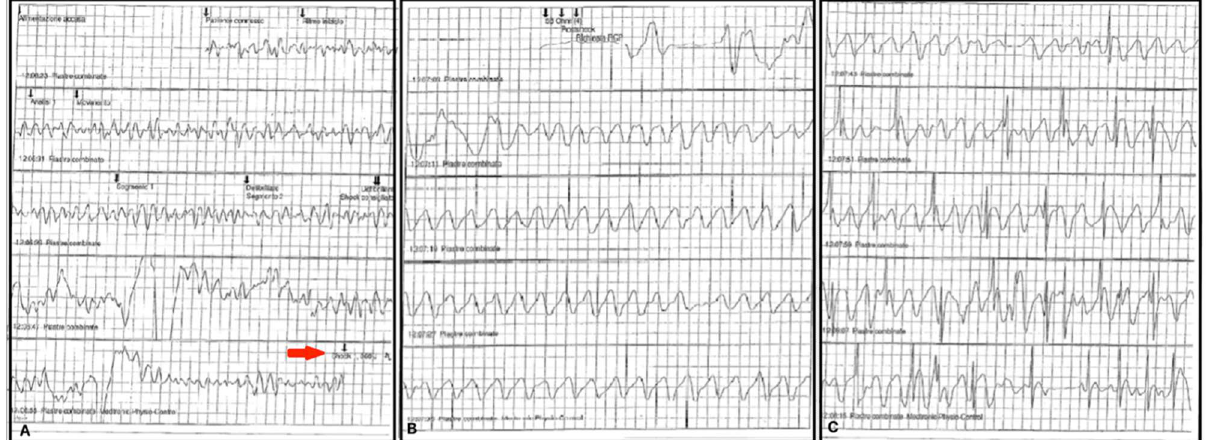
Figure 1. Lifepak-500 (Medtronic, Minneapolis, MI, USA) registered traces during CPR maneuvers. ( Panel A) : ventricular fibrillation recognition and subsequent 360J shock discharge (red arrow) by AED. ( Panel B and C) : post-shock normal rhythm restoration and artifacts from chest compressions.